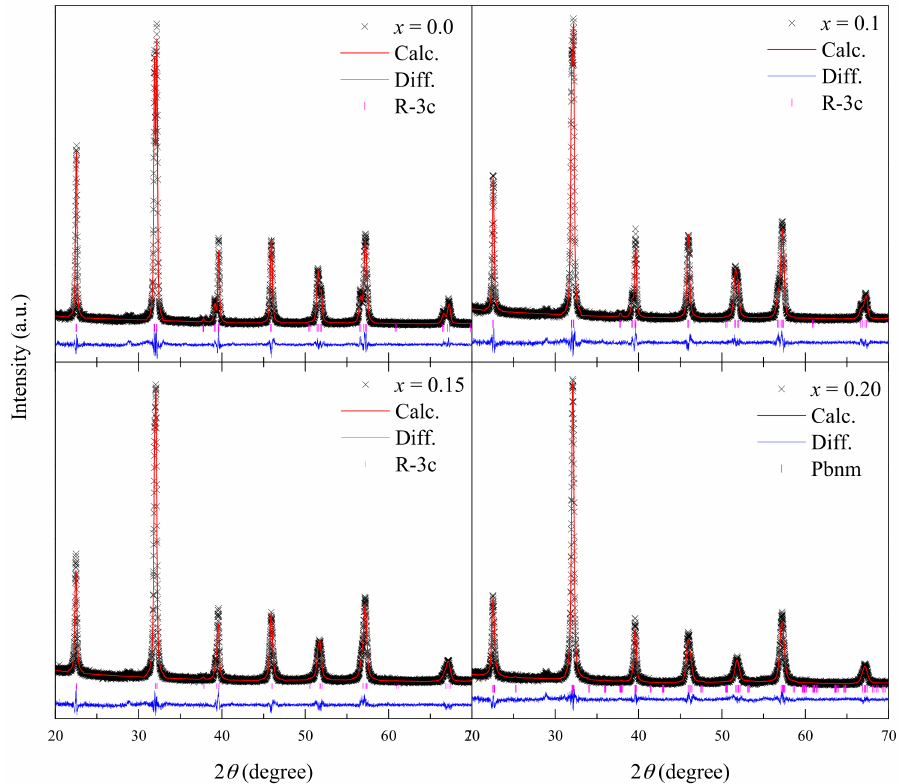
Figure 2. The Rietveld refinement of the XRD patterns for Bi 1 − x La x Fe 0.95 Co 0.05 O 3 samples ( x = 0.05, 0.10, 0.15, and 0.20). Table 1. The refined lattice parameters ( a , b , and c ), goodness of fit ( χ 2 ), and magnetic parameters (saturation magnetization M s , remenant magnetization M r , and coercivity H c ) for all samples. x = 0.0 x =